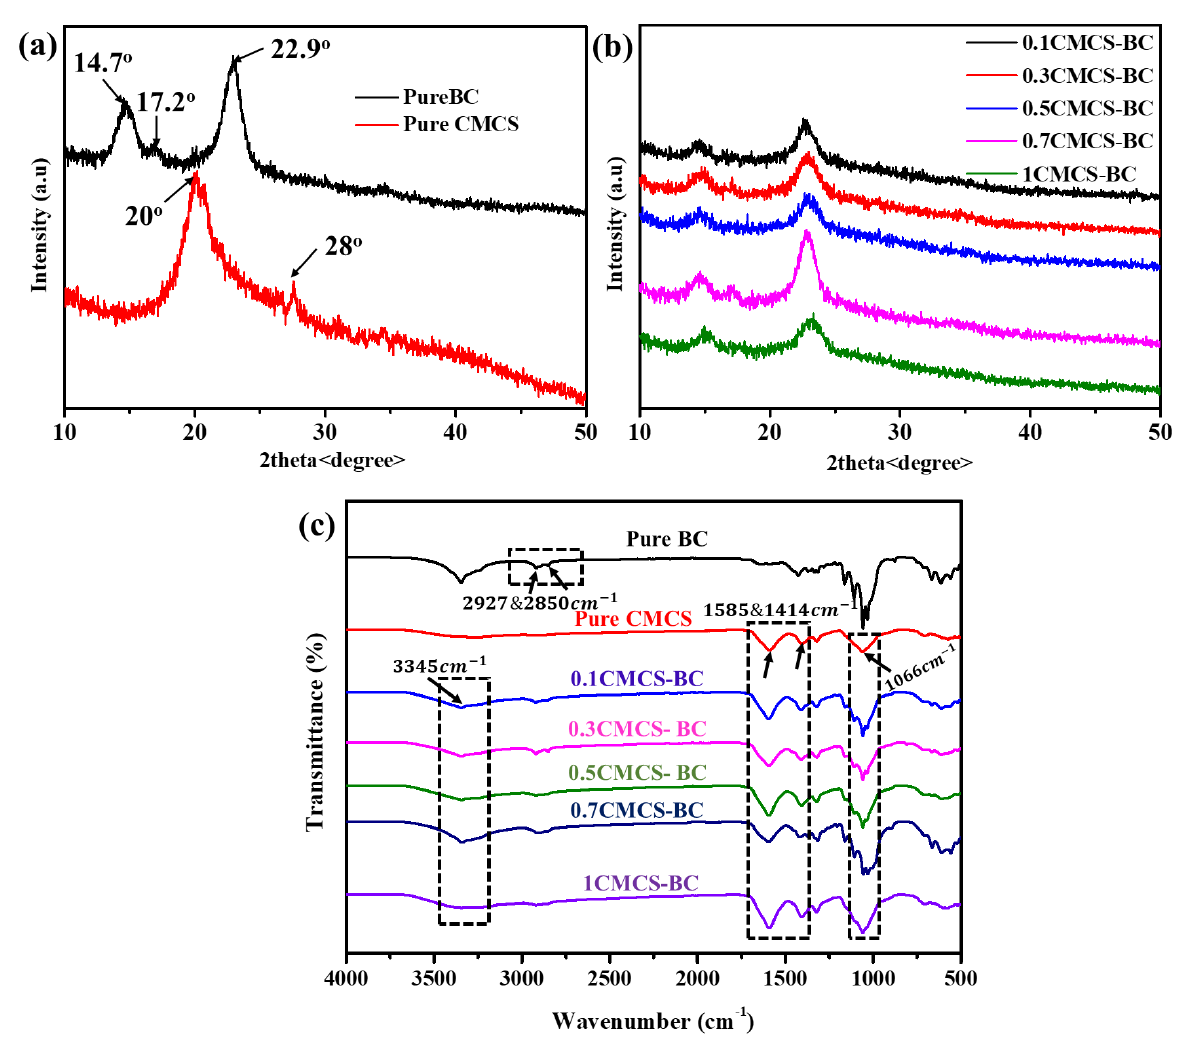
Figure 1. XRD patterns of pure BC and CMCS ( a ), CMCS-BC hydrogels ( b ), and ( c ) FTIR spectra of CMCS-BC hydrogels.